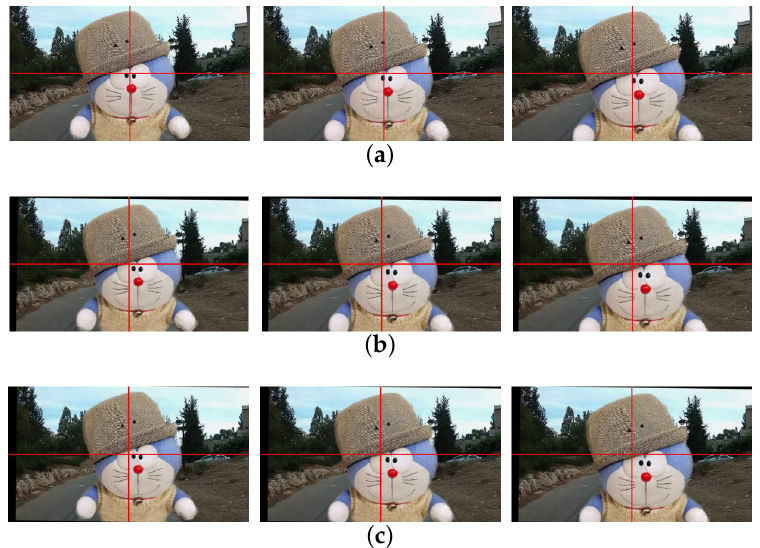
Figure 10. Experiment results of different video stabilization methods: ( a ) shaky video frames with large foreground occlusion (66th, 67th, and 68th frames), ( b ) the stabilized video of [10], ( c ) our method.